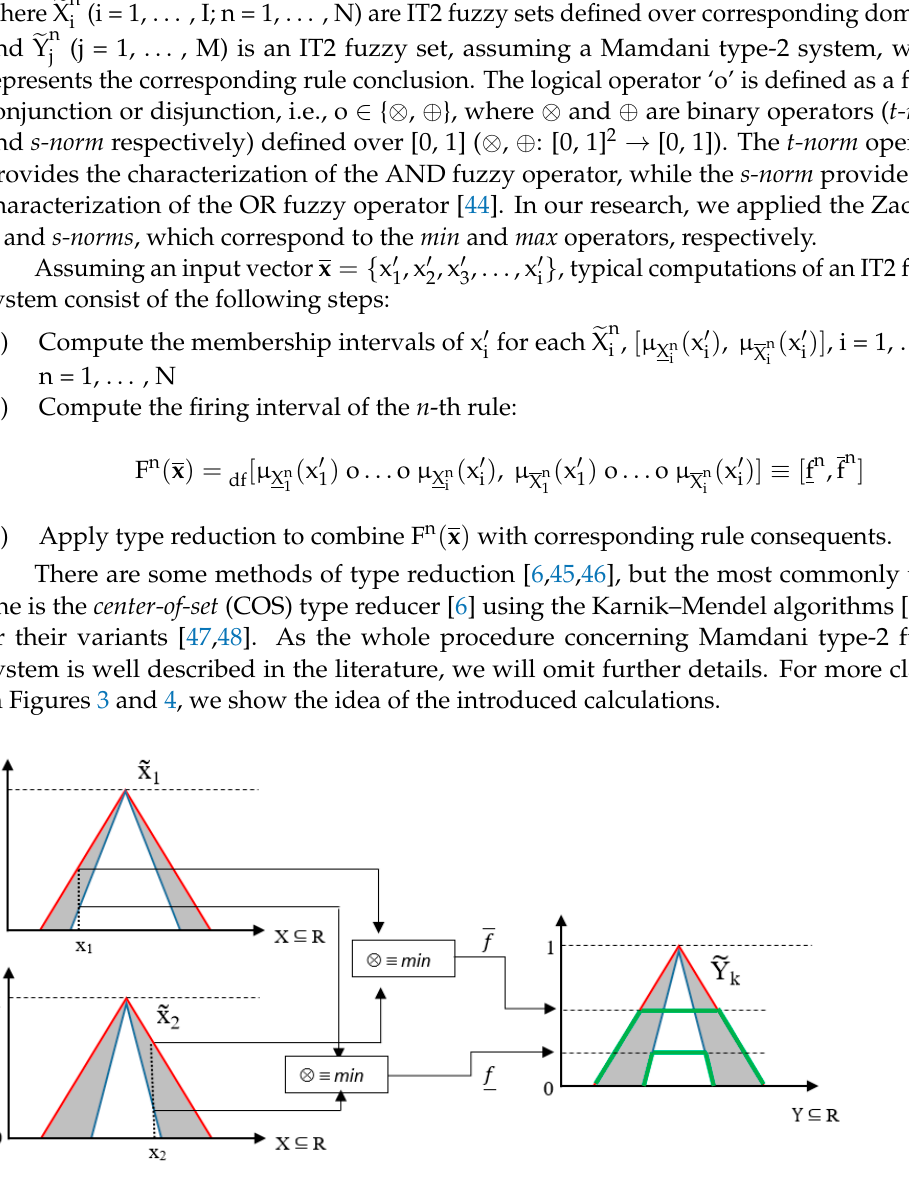
Figure 4. Combined FOU for two sample rules with two interval type-2 (IT2) sets in the conclu- sions. The final system output is defined as (y l + y r )/2, where y l and y r are calculated with respect to L and R values, which can be determined using the Karnik–Mendel algorithm. 2.2.3. Rule Induction with Information Systems An information system [12] is defined by the elements: ( U , A , V , f ), where U is a uni- verse, A is a set of attributes, V represents attributes domains: V= df ⋃ V aa , with nonempty domain V a of the a -th attribute ( a ∈ A ) and f is the so called information function f : U × A → V , ∀ x ∈ U, a ∈ A f(u,a) ∈ V a . Important role in information systems plays the indiscernibility bi- nary relation , which is an equivalence relation, defined over U : IND(B) = df {(x, y) ∈ U × U : ∀ a ∈ B f ( x,a ) =f (cid:3435) y,a (cid:3439) }, under which the lower and upper approximations of any subset of U can be defined, respectively: